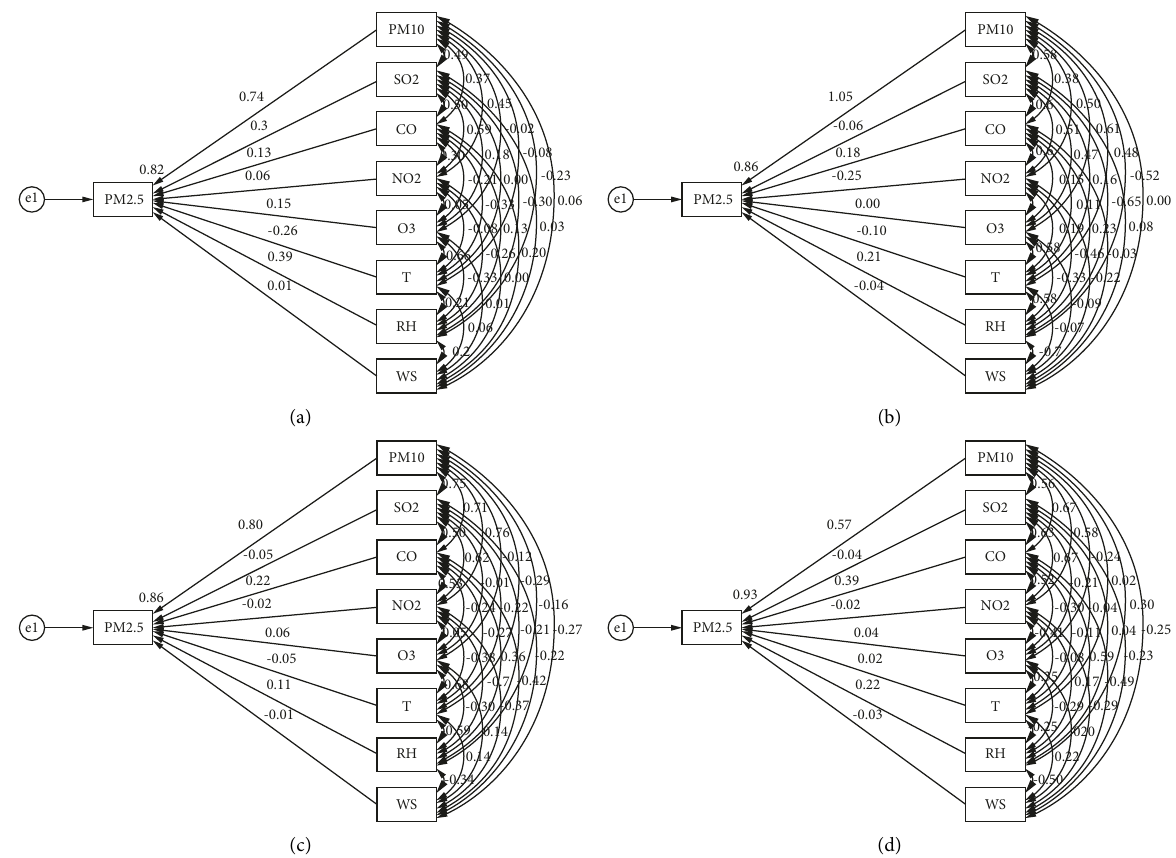
Figure 6: Path analysis of different pollutants and main meteorological factors ( T speed). Table 2: Correlation among six air pollutants under different AQI value ranges; represents a significance level of 0.05 ( P ∗